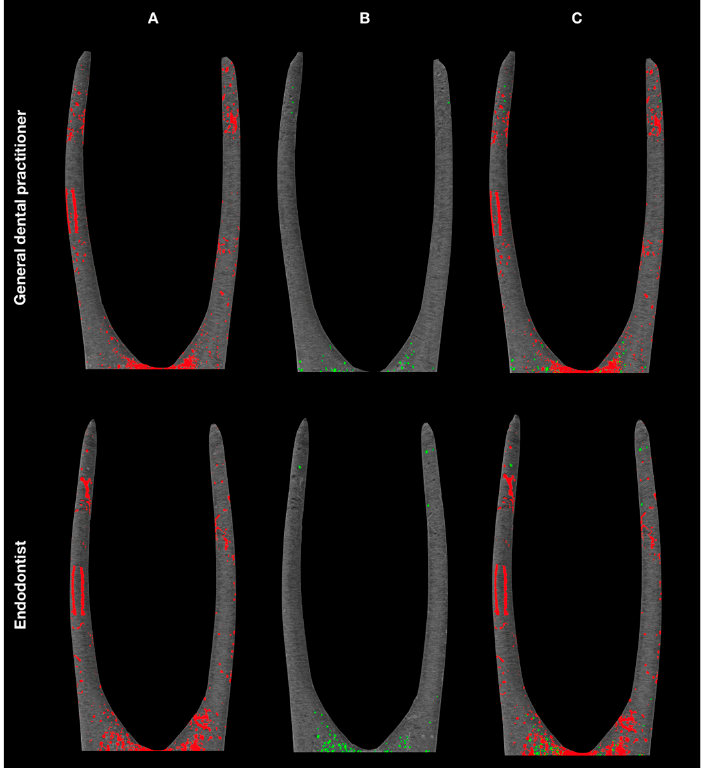
Figure 2. 3D reconstructions demonstrate the distribution of open ( A , red) and closed ( B , green) pores, and overall porosity ( C , superimposed picture) of root-canal fillings in GDP and ED groups.